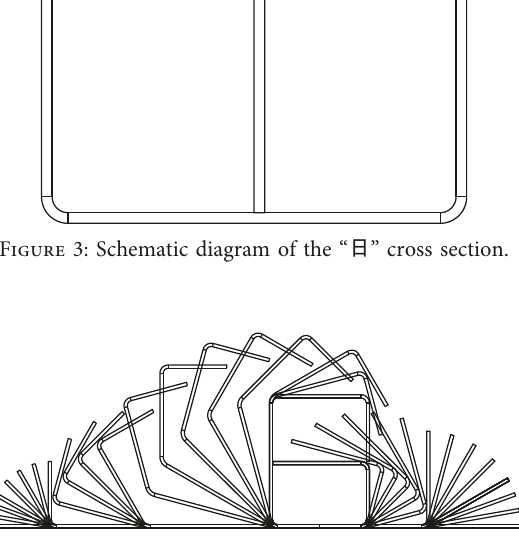
Figure 4: Processing sequence diagram of “ 日 ” shape cross-section products.